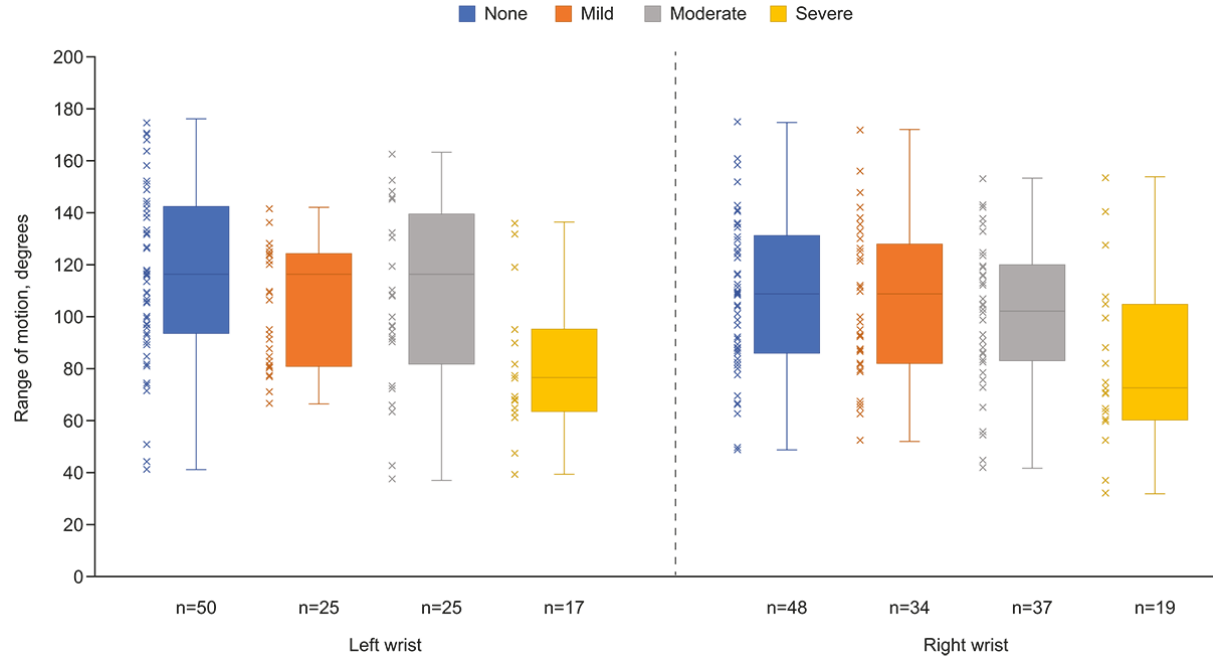
Figure 5. Association between patient wrist range of movement and reported level of wrist pain from the joint pain map assessment at week 1. Boxes represent the upper and lower quartiles; the line inside each box represents the median; the whiskers extending vertically from the boxes represent the